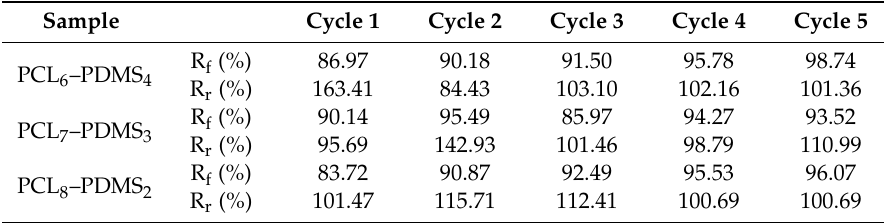
Figure 6. The shape memory behaviour of PCL–PDMS copolymer nanofibres: ( a ) one complete cycle as a function of time; ( b ) strain profile in five thermomechanical cycles. Table 4. Shape recovery ratio (R r ) and shape fixity ratio (R f ) of the PCL–PDMS copolymer nanofibres for five thermomechanical cyclic tests.